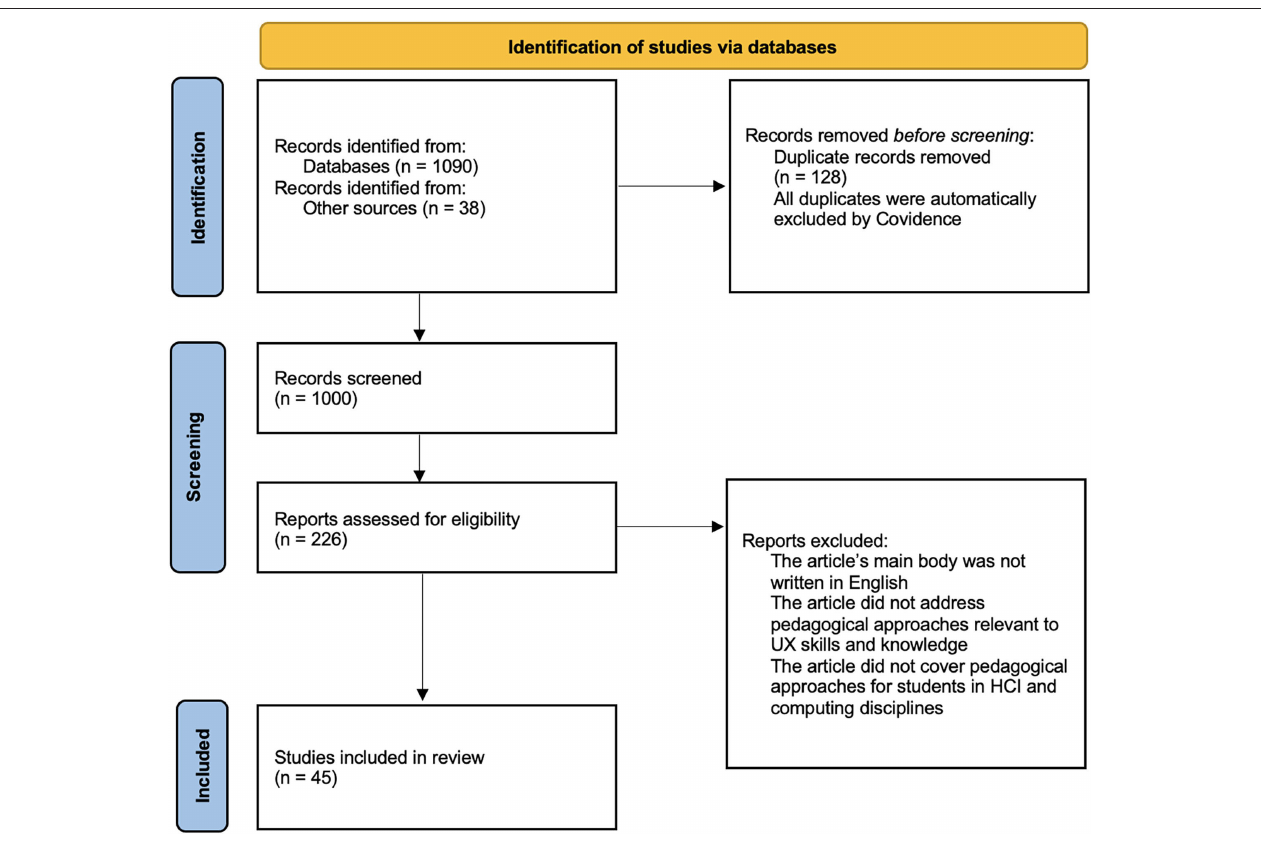
FIGURE 1 | A flow diagram illustrating the article screening